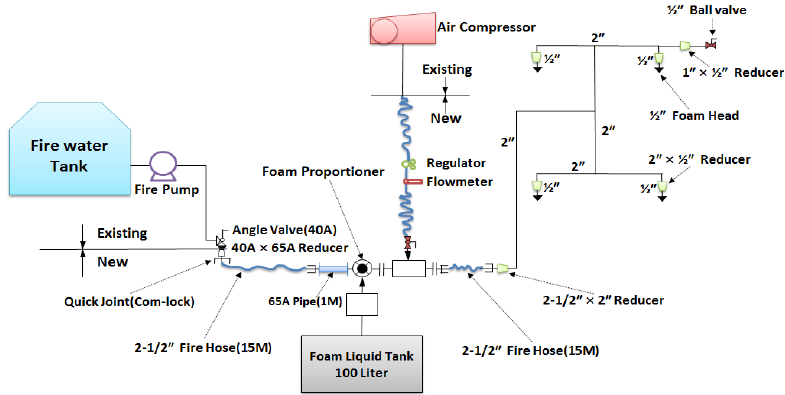
Figure 1. Operating principle of the compressed air foam system.